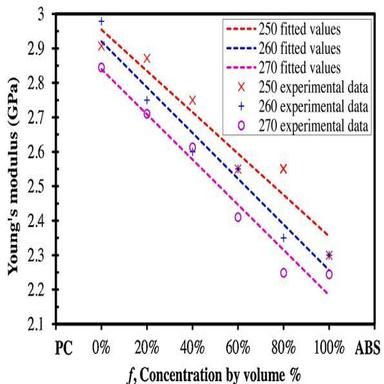
Young's Modulus of PC/ABS material compositions printed at different temperatures.